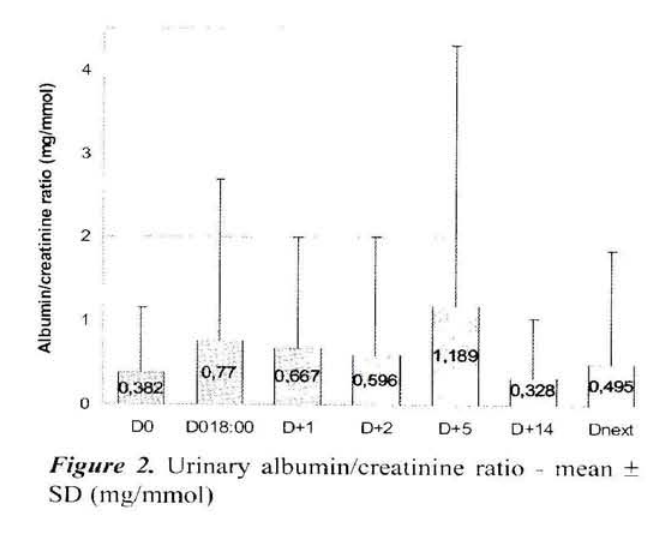
Figure 2. Urinary albumin/creatinine ratio - mean ± SD (mg/mmol)